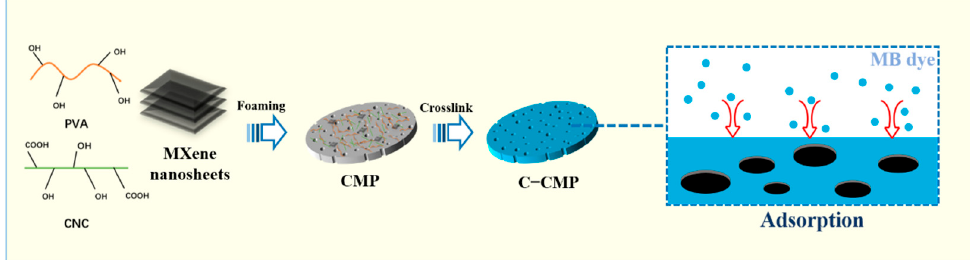
Figure 1. Preparation process of cross–linked cellulose nanocrystals (CNC)/MXene/polyvinyl alcohol (PVA) (C–CMP) composite foam.